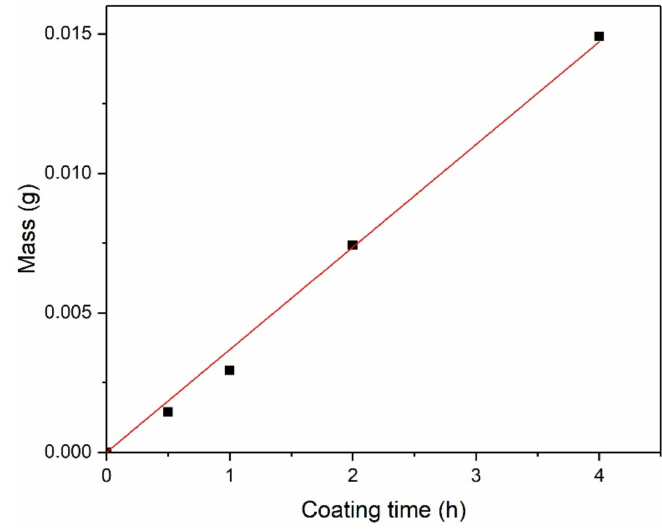
Figure 4. Variation of the CoFe mass as a function of coating time.